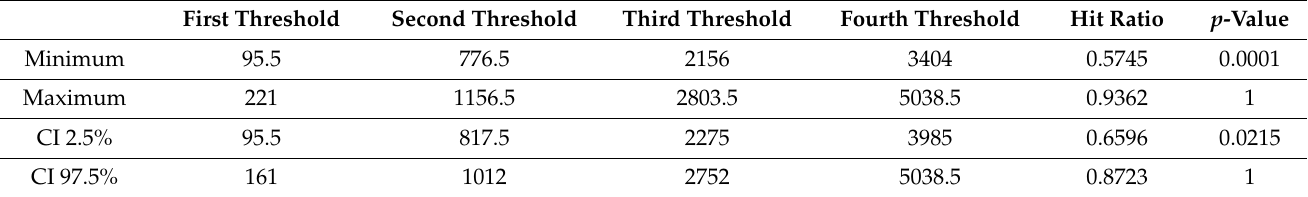
Table 3. Determining the thresholds of different endometritis severity categories using the digitally quantified total inflammatory cell numbers. The first threshold value indicates the cell count above which we would score grades 1 and 0 below; therefore, the four threshold values would separate the four endometritis grades. Thresholds, p -values with extreme values, and confidence intervals based on 1000 simulations. The simulations were used to evaluate sensitivity. Two-thirds of the cases were randomly selected to determine the threshold values; then, the hit rate was tested on the remaining 1/3 of whether there were tendency